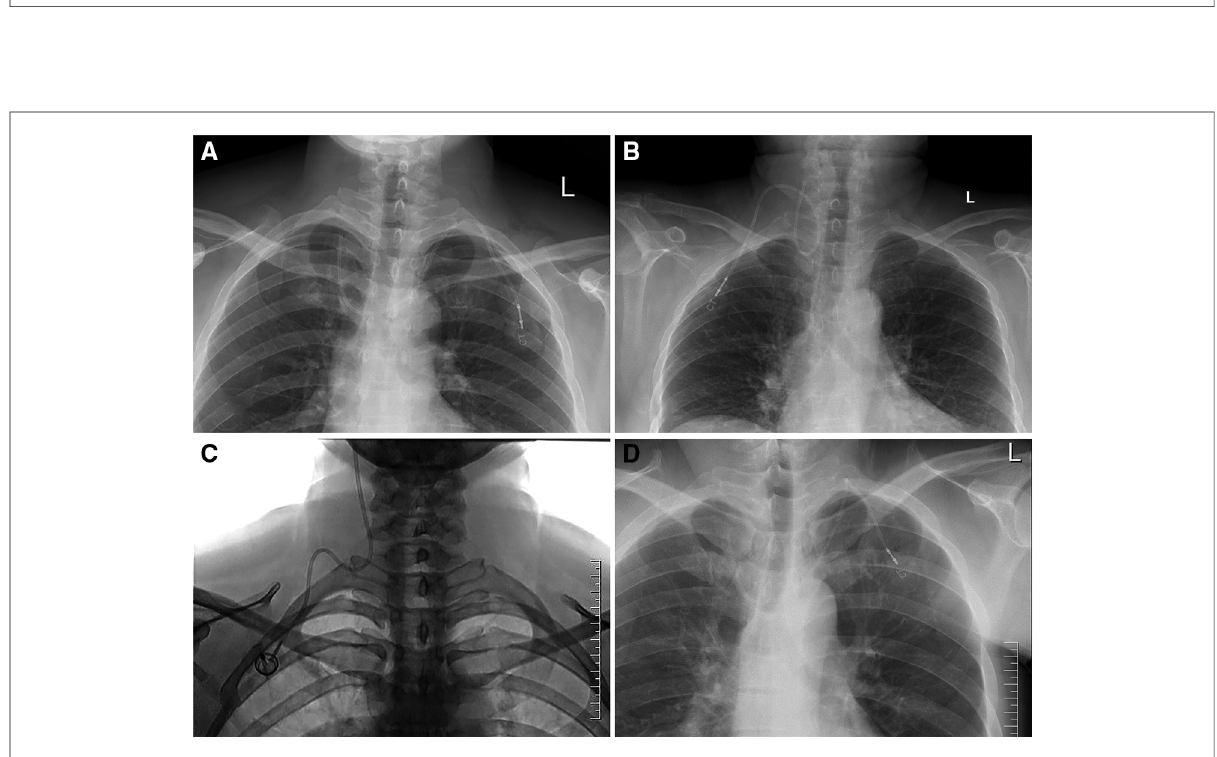
FIGURE 2 Catheter malposition to IJV and brachiocephalic vein. ( A ) The tip of the catheter is located in the contralateral IJV; ( B ) The catheter is turned back, and the tip of the catheter is located in the ipsilateral IJV; ( C ) The catheter is located in the IJV and runs toward the head; ( D ) The tip of the catheter is located in the contralateral brachiocephalic